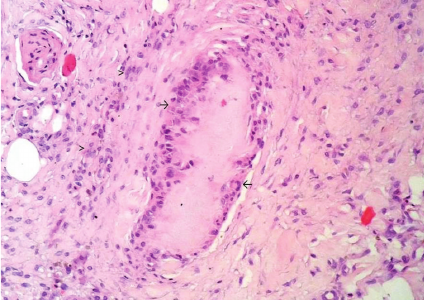
Figure 3: Histopathological findings of the subcutaneous nodule: foreignbodycellreactiontoeosinophilicfibrillarmaterialconsistent with gouty tophi (arrow). In the peripheral area, there is an inflam- matory infiltrate of lymphocytes, plasma cells, and macrophages (arrowhead) (hematoxylin and eosin